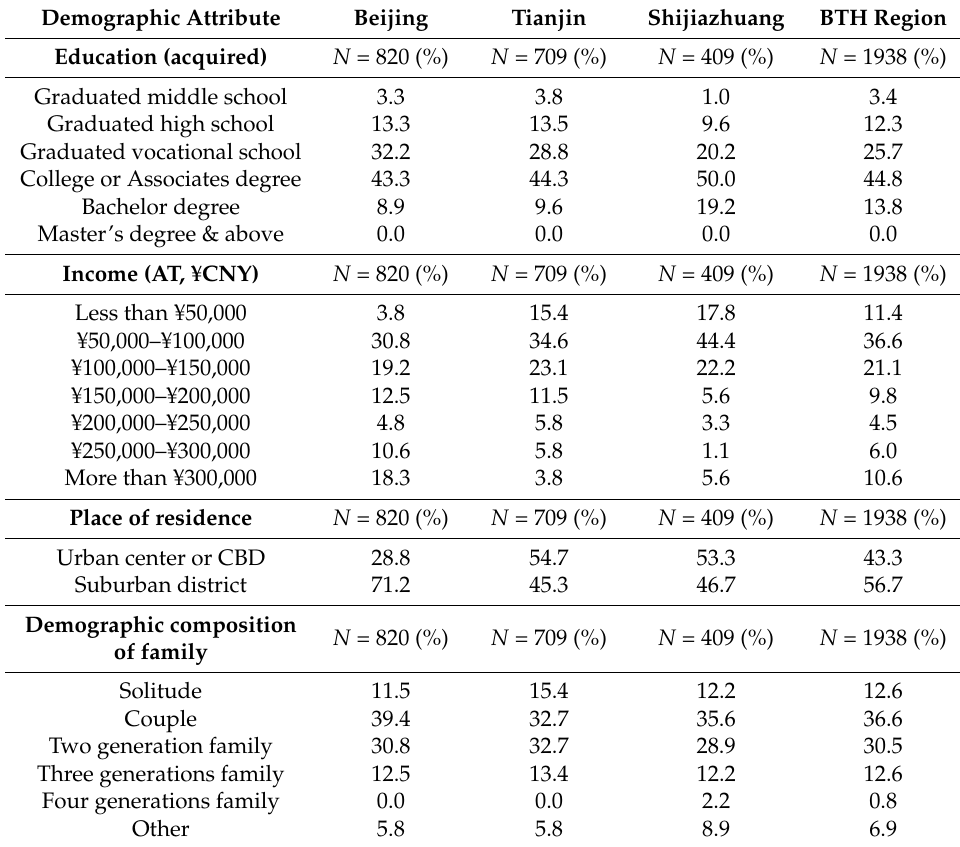
Table 2. Demographics of the survey